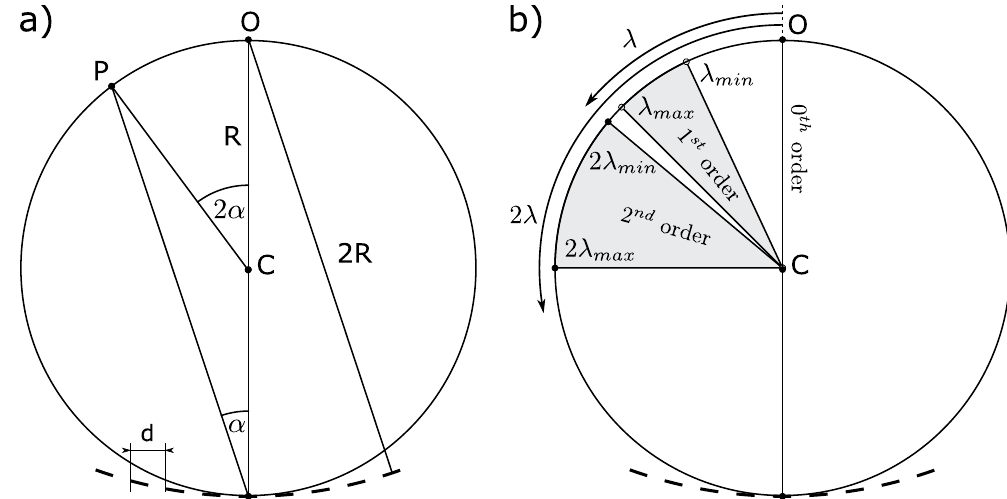
Figure 3. ( a ) Sketch for calculating the resolution of the Rowland circle arrangement. ( b ) Position of the diffraction orders around the Rowland circle. λ min and λ max are the minimal and maximal wavelength components in the input signal. In order to avoid band overlap, λ max < 2 λ min must be